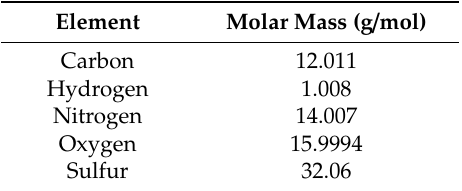
Table 5. The molar mass of selected elements